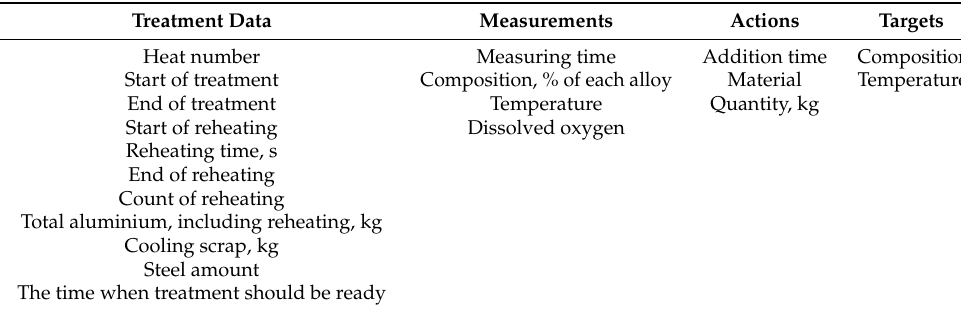
Table 1. Data gathered from CAS-OB historical